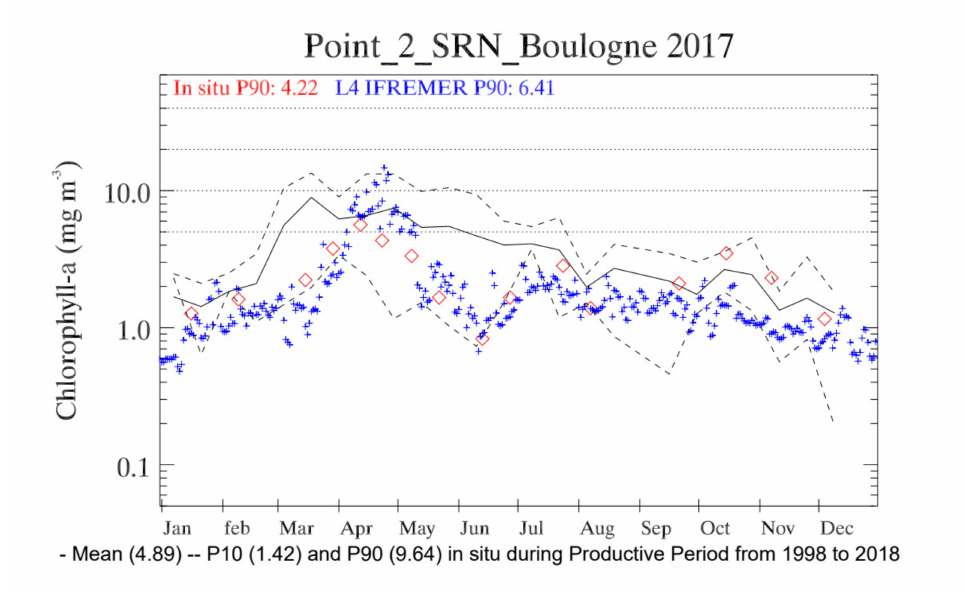
Figure 15. Merged Chl- a concentration derived from MODIS / VIIRS retrievals at Boulogne Point 2 in